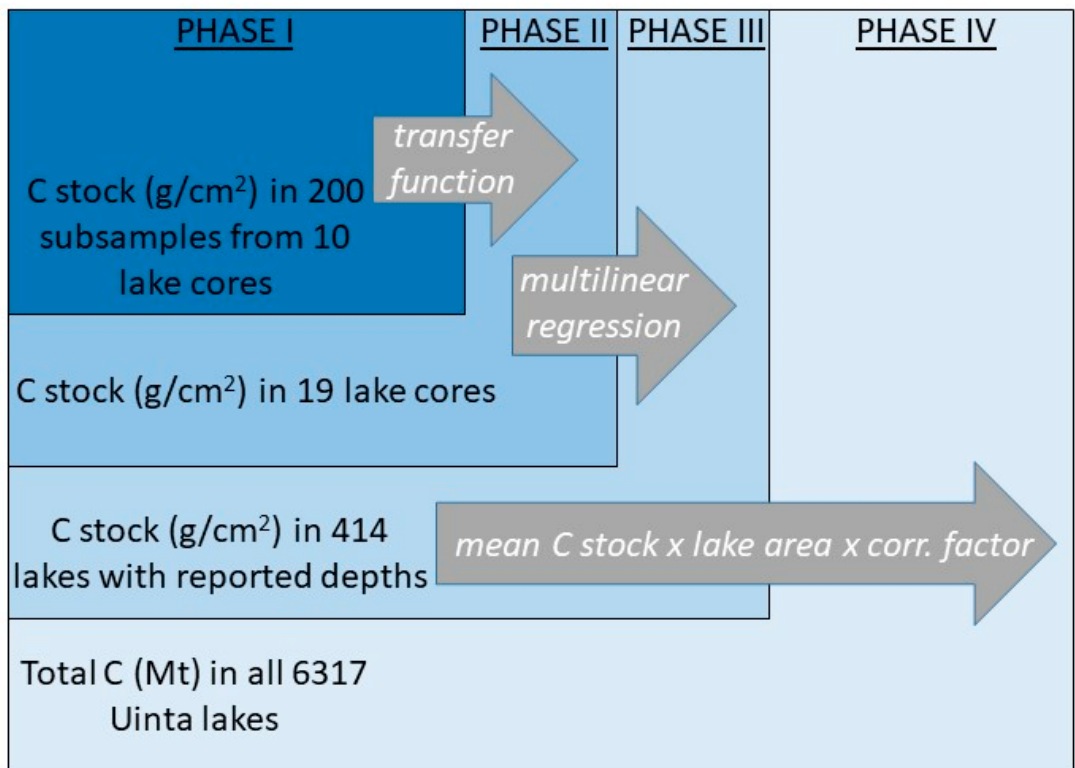
Figure 2. Schematic showing the four phases of extrapolation in this study and the methods employed at each step. at each